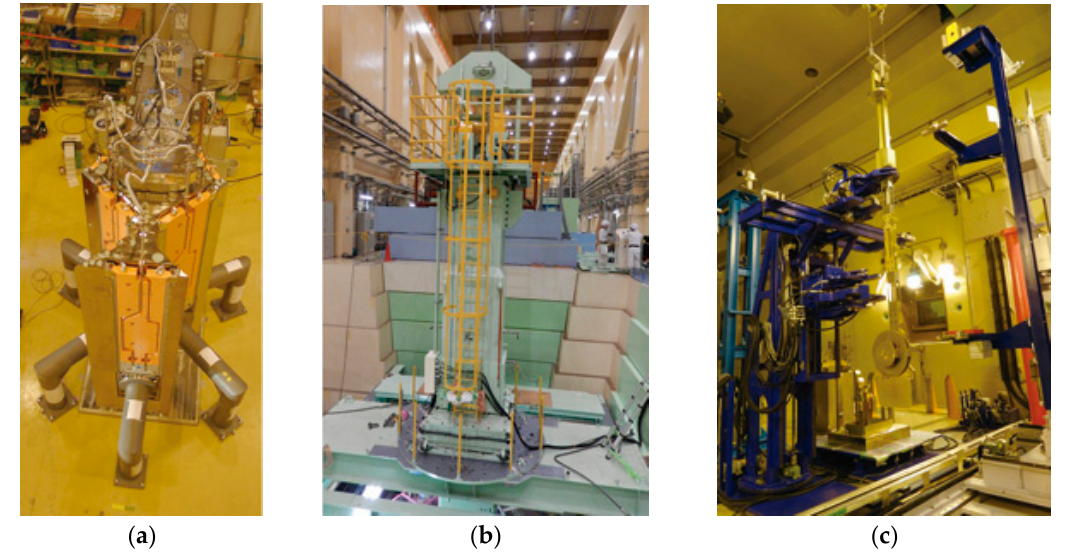
Figure 3. Pictures of ( a ) the target chamber, ( b ) the transfer cask, and ( c ) remote handling commissioning in the hot cell.